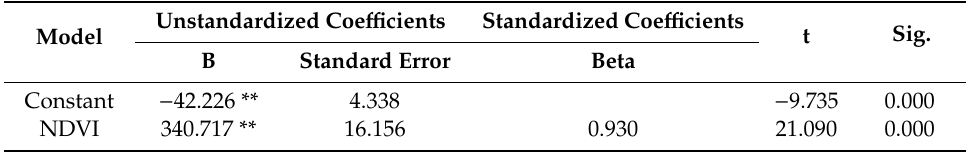
Table 10. Coe ffi cients of the linear regression model between the TCC% and